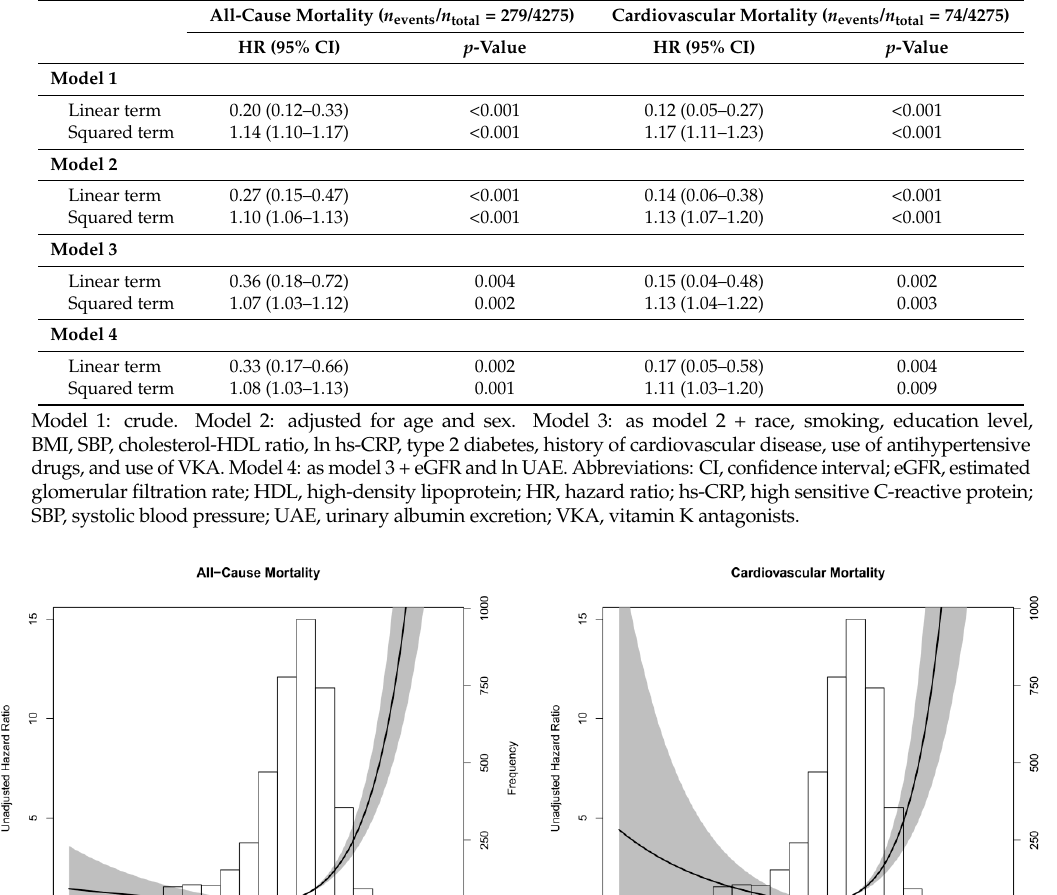
Table 2. Associations of log 2 dp-ucMGP with all-cause and cardiovascular mortality. All-Cause Mortality ( n events / n total = 279/4275)